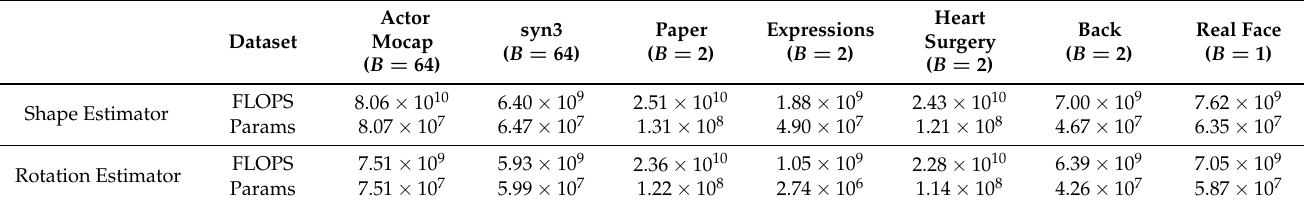
Table 2. Computational complexity analysis of DST-NRSfM model.